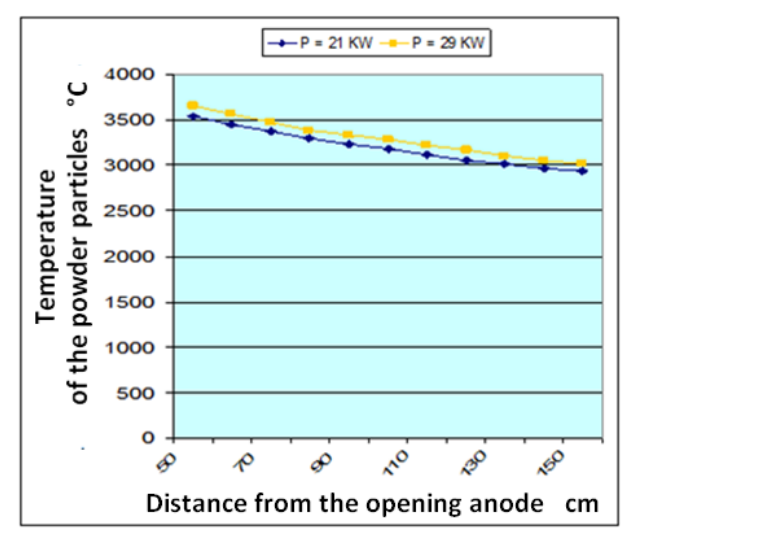
Figure 3 – Surface temperature of Al 2 O 3 particles in plasma with a power of 21 and 29 kW Рис . 3 – Температура поверхности частиц Al 2 O 3 в плазме , мощностью 21 и 29 кВт Слика 3 – Температуре површине честица Al 2 O 3 у плазми , снаге 21 и 29